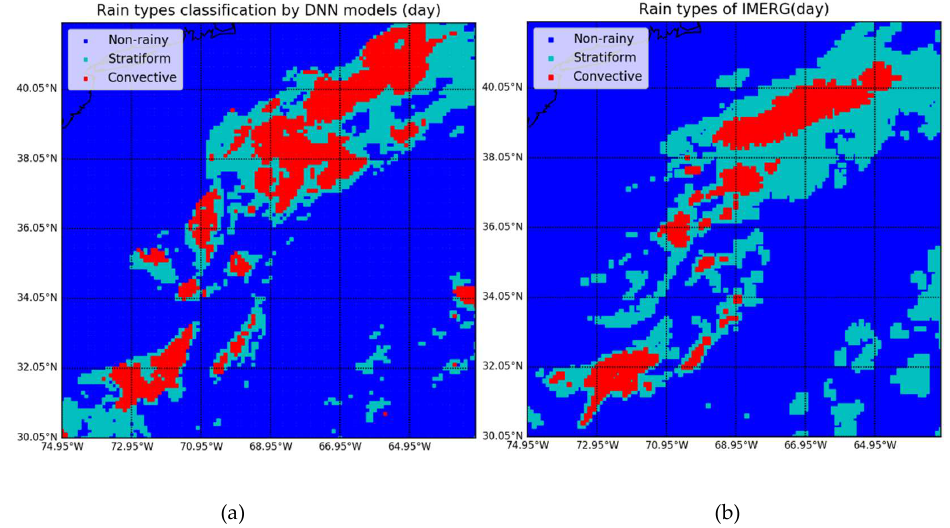
Figure 5. Cloud classification results and IMERG estimations of normal precipitation: ( a ) ABI prediction; and ( b ) IMERG estimation on 19 September 2018, at 18:00–18:30 UTC.